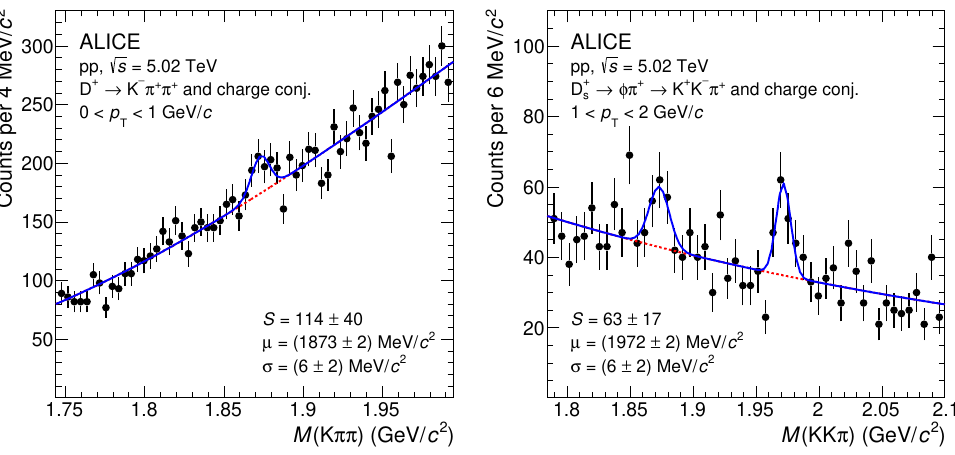
Figure 4 . Invariant-mass distributions of D + and D + candidates and charge conjugates in the s intervals 0 < p T < 1 GeV /c and 1 < p T < 2 GeV /c , respectively. The blue solid lines show the total fit functions as described in the text and the red dashed lines are the combinatorial-background components. The values of the mean ( µ ) and the width ( σ ) of the signal peak are reported together with the raw yield ( S ). The reported uncertainties are only the statistical uncertainties from the